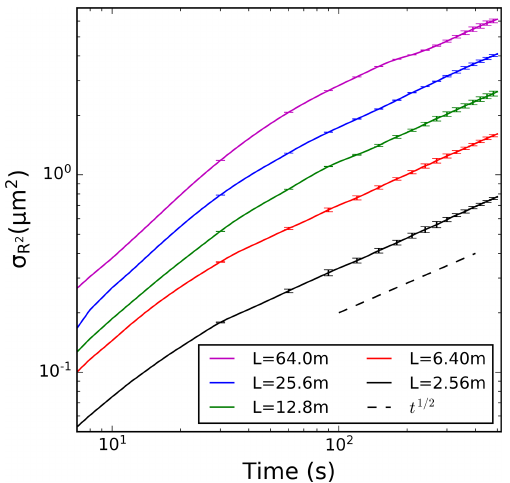
Figure 9. Evolutions of the radius squared standard deviation σ R 2 for different domain sizes in the scaled-up DNS simulations. Hori- zontal bars along each line show variability resulting from the dif- ferent multiplicity used for each domain